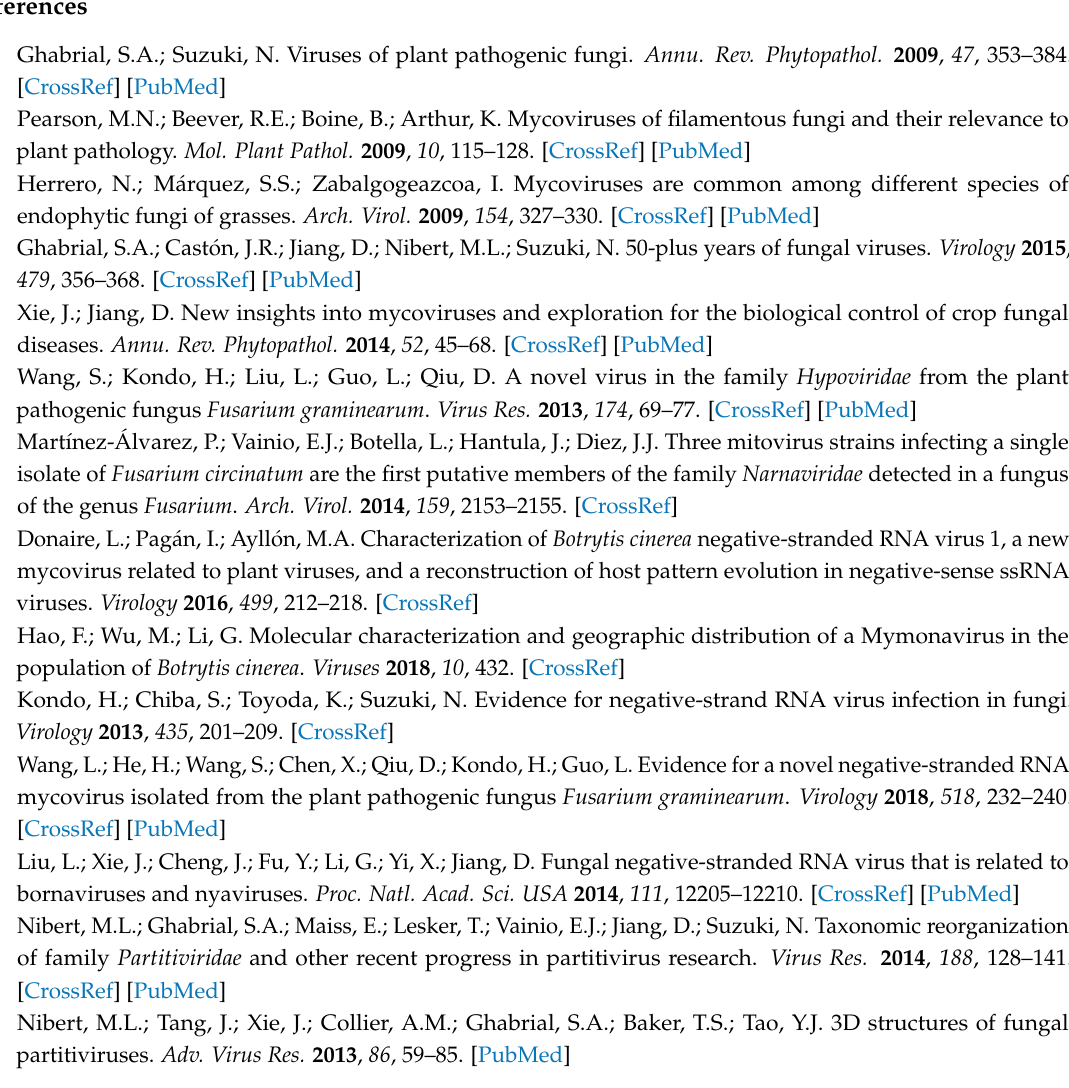
Figure S1: Phenotypic and molecular characterization of bikaverin biosynthesis in the pink-colored isolate QT5-19 of Botrytis cinerea (A) Difference between QT5-19 and B05.10 in accumulation of the pink pigment on potato dextrose agar (20 ◦ C) (B) RT-PCR detection of expression of the genes ( bcbik1 to bcbik6 ) responsible for biosynthesis of the pink pigment bikaverin. The primers for related genes used in RT-PCR are listed in Table S1. (C) A schematic diagram showing the bikaverin-biosynthesis gene cluster in isolates QT5-19 and B05.10. The gray-colored region indicates the absence of bcbik1 in B05.10. Arrows indicate the direction of gene transcription. Figure S2: Alignment of the partial nucleotide sequences of bcbik1 coding for polyketide synthase (PKS) in isolates QT5-19 and 1750 of Botrytis cinerea , and the homologs of bcbik1 in Fusarium oxysporum and Fusarium anthophilum . Figure S3: Pathogenicity of isolates QT5-19 and B05.10 of B. cinerea on fruits of tomato, table grape and apple, and on leaves of cucumber, rapeseed and strawberry. Figure S4: A schematic diagram showing the strategy for cDNA cloning of the full-length sequences of the two dsRNAs in Botrytis cinerea partitivirus 2 (BcPV2). Figure S5: Northern-blotting detection of the dsRNAs extracted from the mycelia of Botrytis cinerea QT5-19. Figure S6: Detection of BcPV2 in different isolates of Botrytis cinerea by dsRNA profiling and RT-PCR. Table S1: List of the oligonucleotide primers or adaptor used in this study. Table S2: List of partitiviruses for multiple sequence alignment and phylogenetic